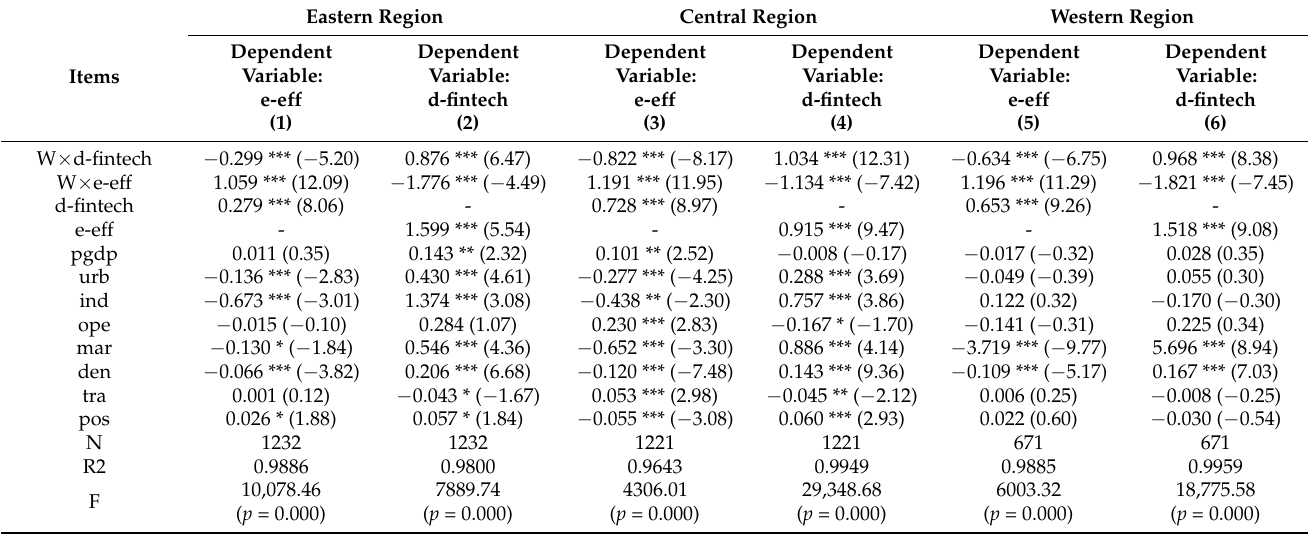
Table 9. Regional estimation results of GS3SLS (spatial weight of geographical distance).